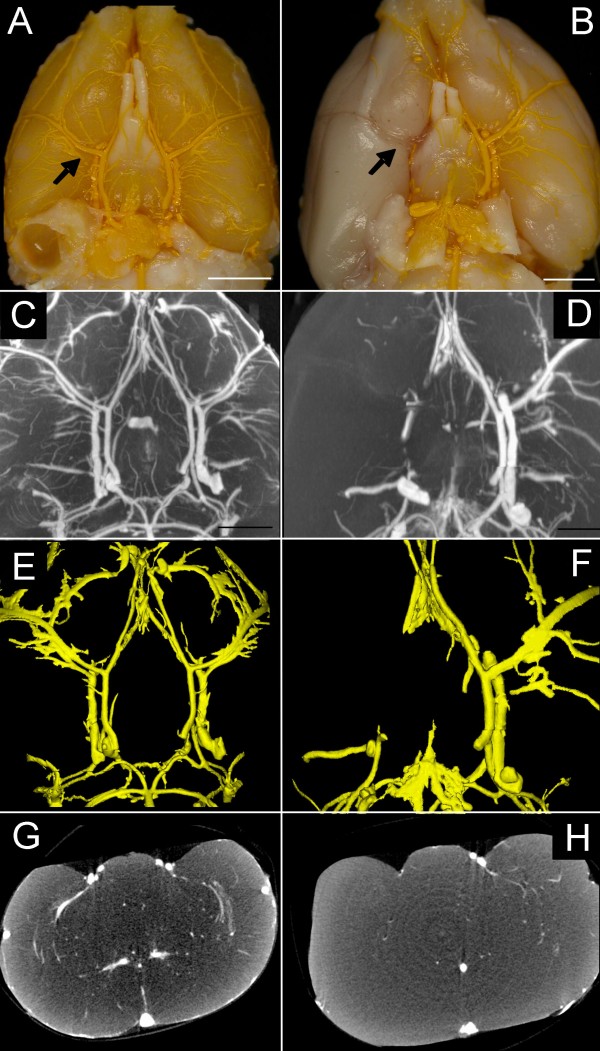
Macroscopic photograph of the rat brain from controls (A) and the suture model (B, bar = 4 mm). The suture has been removed and after contrast perfusion, the occluded right part of the circle of willis and the branching middle cerebral artery are demonstrated. Maximum intensity projection (C, D), surface-rendering (E, F) and coronar single-slice micro-CT demonstrate the occluded middle cerebral artery (D, F, H) compared to controls (C, E, G).